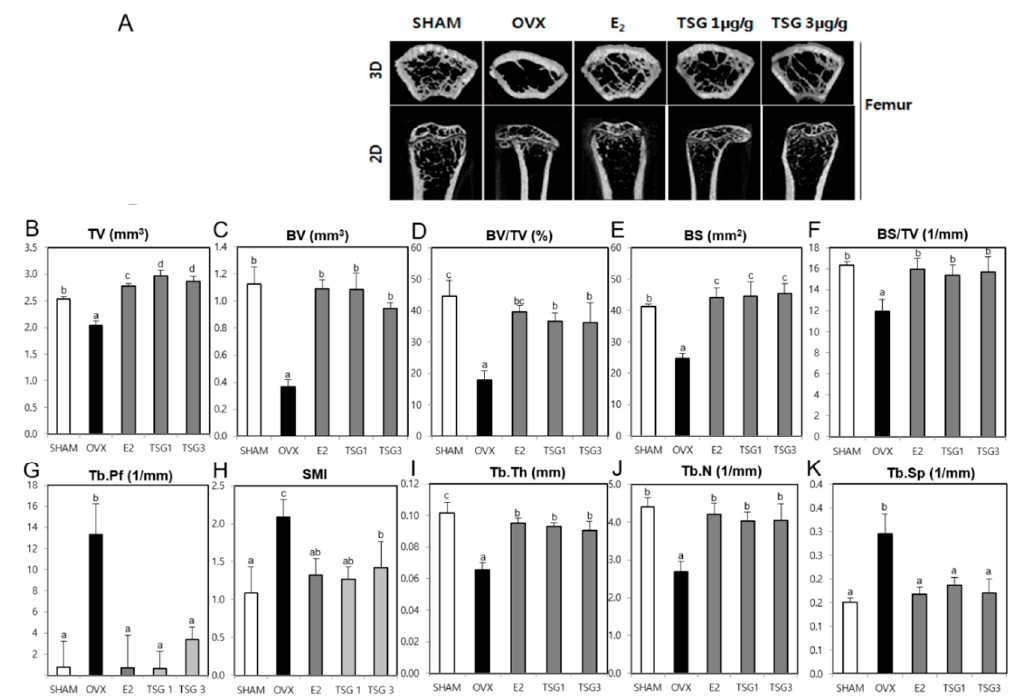
Figure 5. Effect of TSG on the trabecular morphometric parameters in the distal femur of C3H/HeN mice. The mice were treated with vehicle and TSG (1 and 3 µ g/g/day, physiological phosphate [IP]) for six weeks. ( A ) The representative two-dimensional (2D) images and three dimensional (3D) images of the femur epiphysis, ( B ) tissue volume, ( C ) bone volume, ( D ) bone volume/tissue volume, ( E ) bone surface, ( F ) bone surface/tissue volume, ( G ) trabecular pattern factor, ( H ) structure model index, ( I ) trabecular thickness, ( J ) trabecular number, and ( K ) trabecular separation, as analyzed by the micro-computed tomography (CT) Skyscan CTAn software. a, b, and c: The means not sharing a common letter are significantly different among groups at p < 0.05 by one-way ANOVA with Duncan’s multiple-range test.